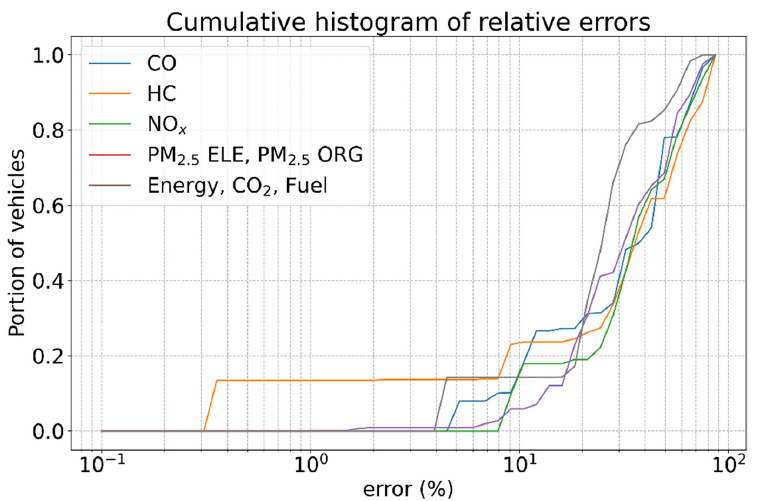
Figure 6. Cumulative histograms of errors of emission estimations based on the speed estimations computed by our system.